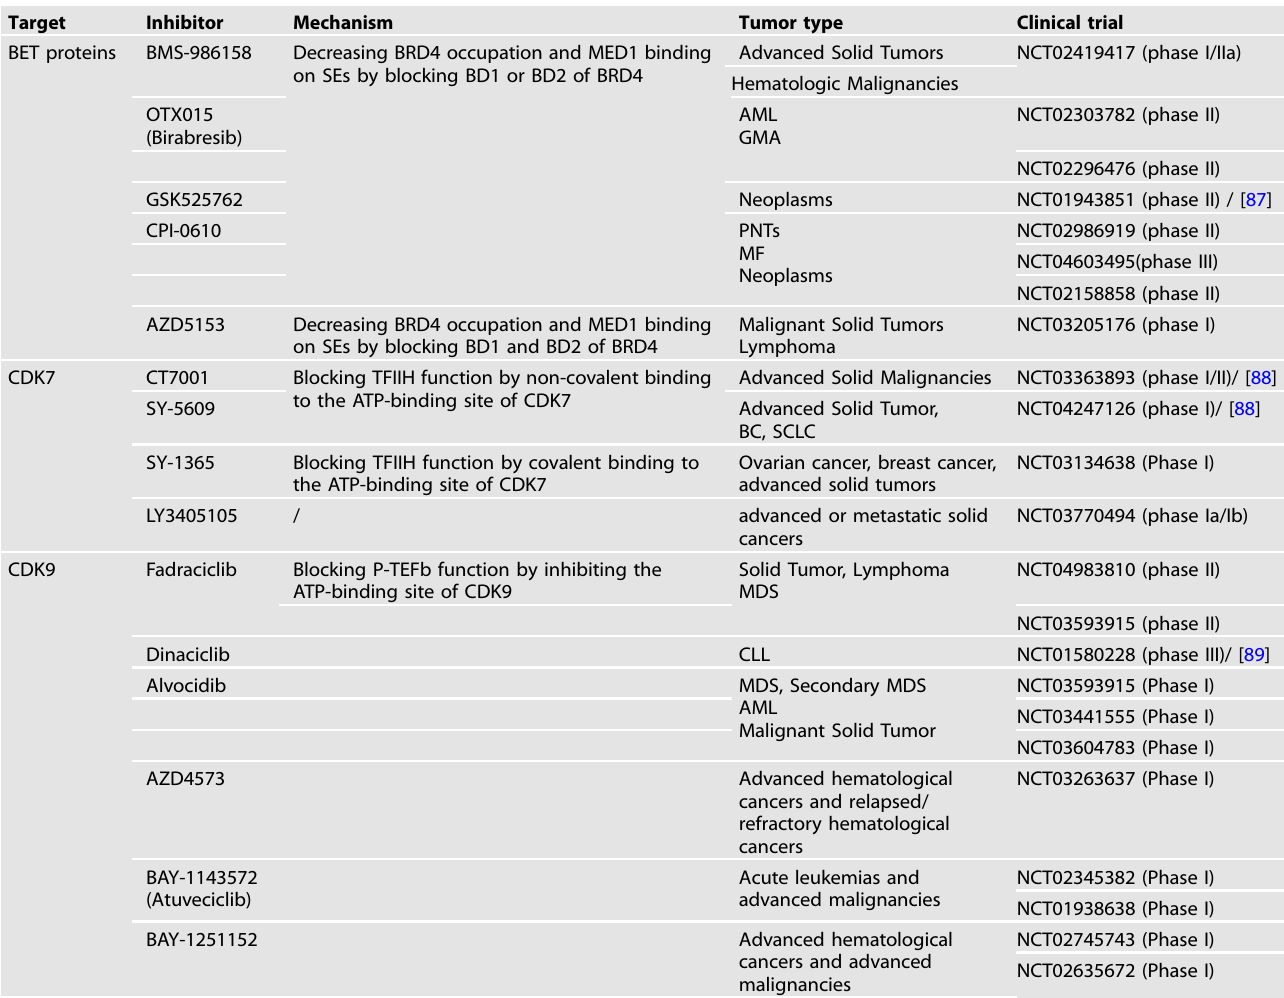
Table 2. SEs-targeting therapeutic inhibitors in clinical